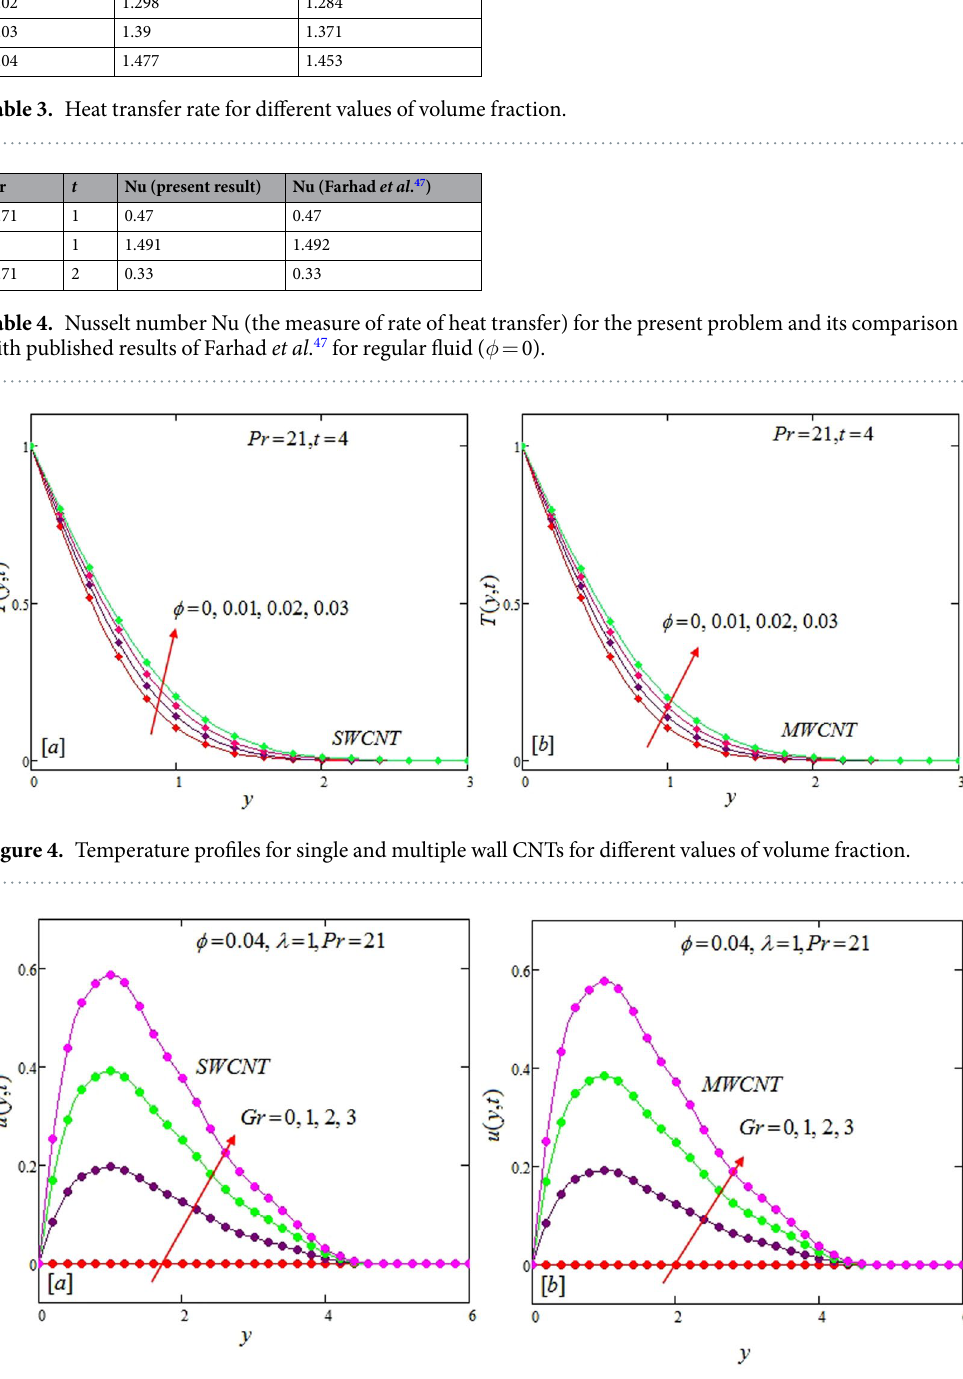
Figure 5. Velocity profiles for single and multiple wall CNTs for different values of Grashoff